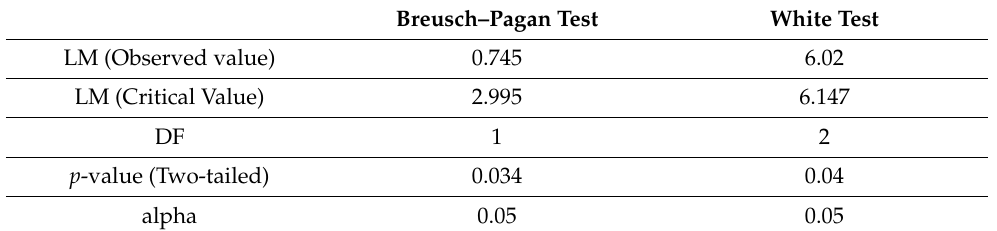
Table 6. Results of the heteroscedasticity